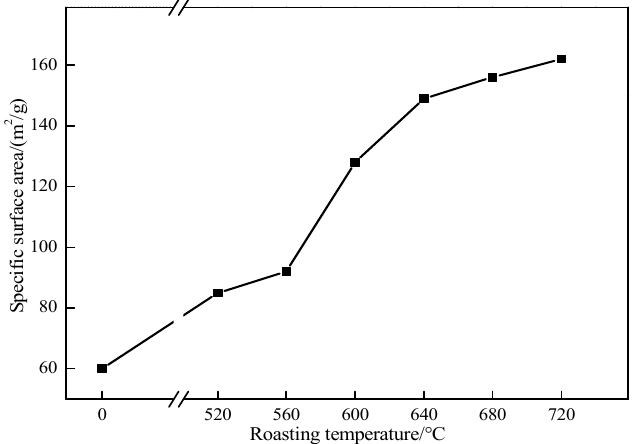
Figure 10. The trend of α -Al 2 O 3 microcrystallite size change in ore roasted at varying temperatures.